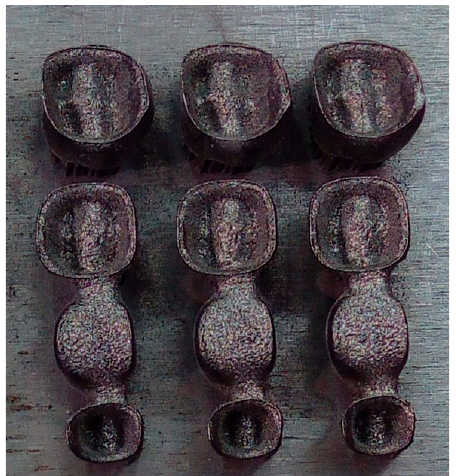
Figure 10. Crown and dental bridge printed via SLM with titanium alloy. Reprinted with permission from Ref. [166]. Copyright 2017, copyright Zhou H, Fan Q.